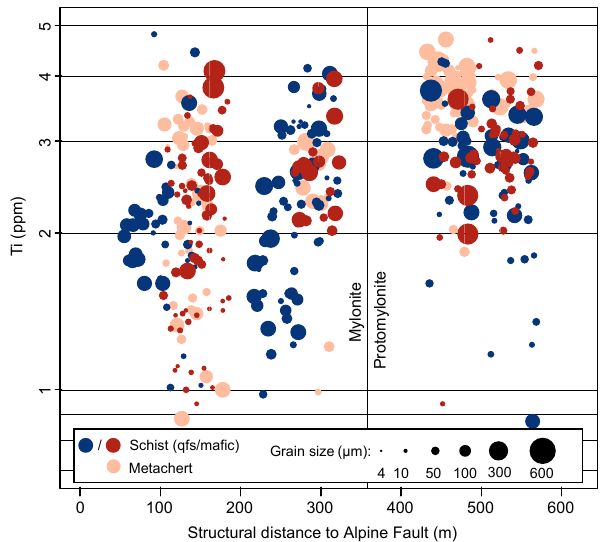
Figure 5. Ti concentrations vs. distance to the Alpine Fault, with analyses colored as a function of sample composition. With the ex- ception of two protomylonite metachert samples with high Ti (at ∼ 450 and 550m), no systematic effect of composition is evident. Samples at structural distances > 600m are not plotted because they are uniformly quartzofeldspathic (qfs). The data are jittered along the x axis by an amount not exceeding 30km in order to increase the visibility of the data.